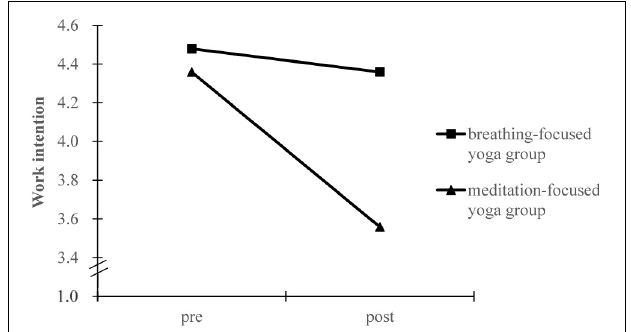
FIGURE 1 | Marginal means estimated for work intention before and after intervention by group.